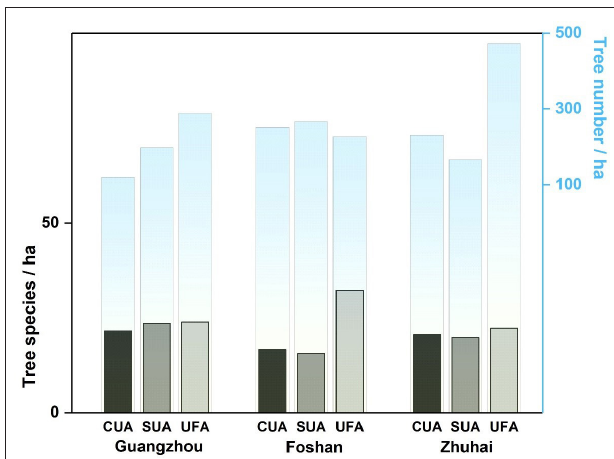
FIGURE 2 | The density of tree species (/ha) and density of tree numbers (/ha) in CUA, SUA, and UFA of the three cities, respectively. The bars in dark gray, medium gray, and light gray are the densities of tree species that follow the left black y-axis while the light blue bars representing the density of tree numbers match the right blue